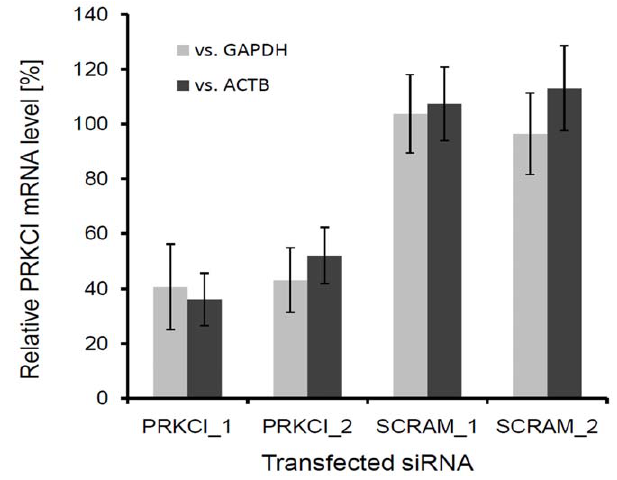
Figure 3. Quantitative RT-PCR verification of PRKCI knock- down by the siRNA duplexes. The bars represent the mean and standard deviations from two independent experiments. PRKCI_1, siRNA duplex # 1 targeting PRKCI; PRKCI_2, siRNA duplex # 2 targeting PRKCI; SCRAM_1, scrambled siRNA duplex # 1; SCRAM_2, scrambled siRNA duplex # 2. The light bars represent normalization to GAPDH and the dark bars represent normalization to ACTB.